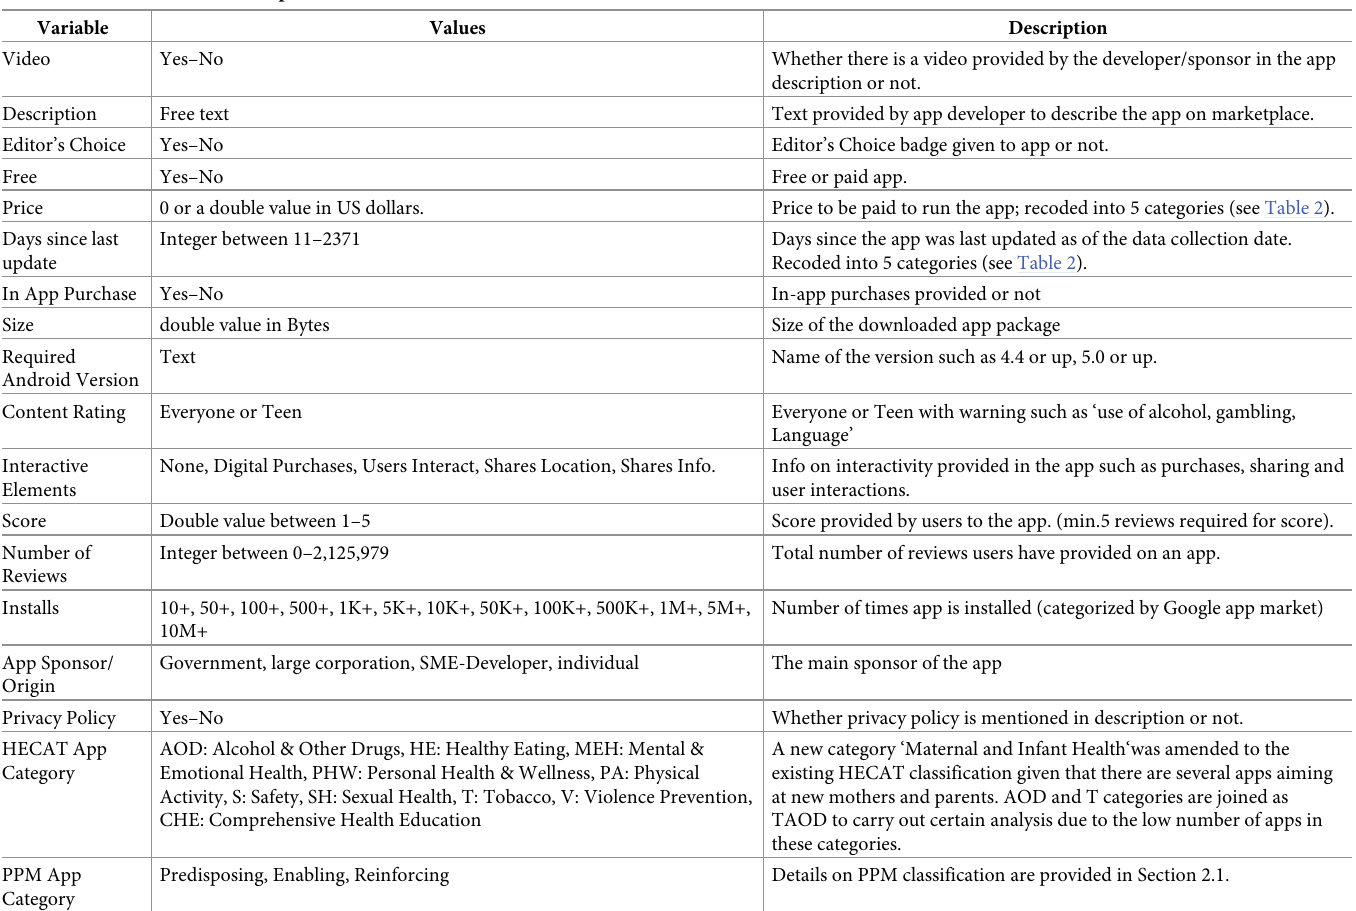
Table 1. Code sheet: Metrics and parameters. Variable Values